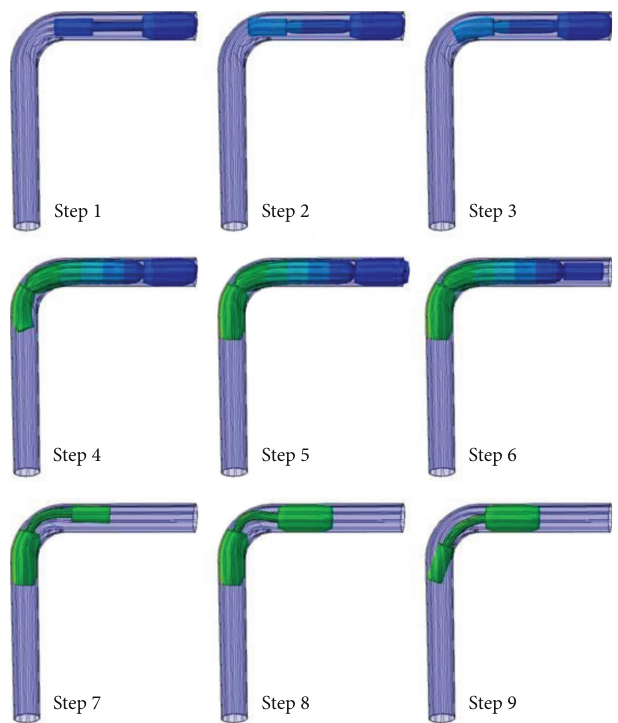
F IGURE 14: Crawling in a bent pipe with 90 ° bend